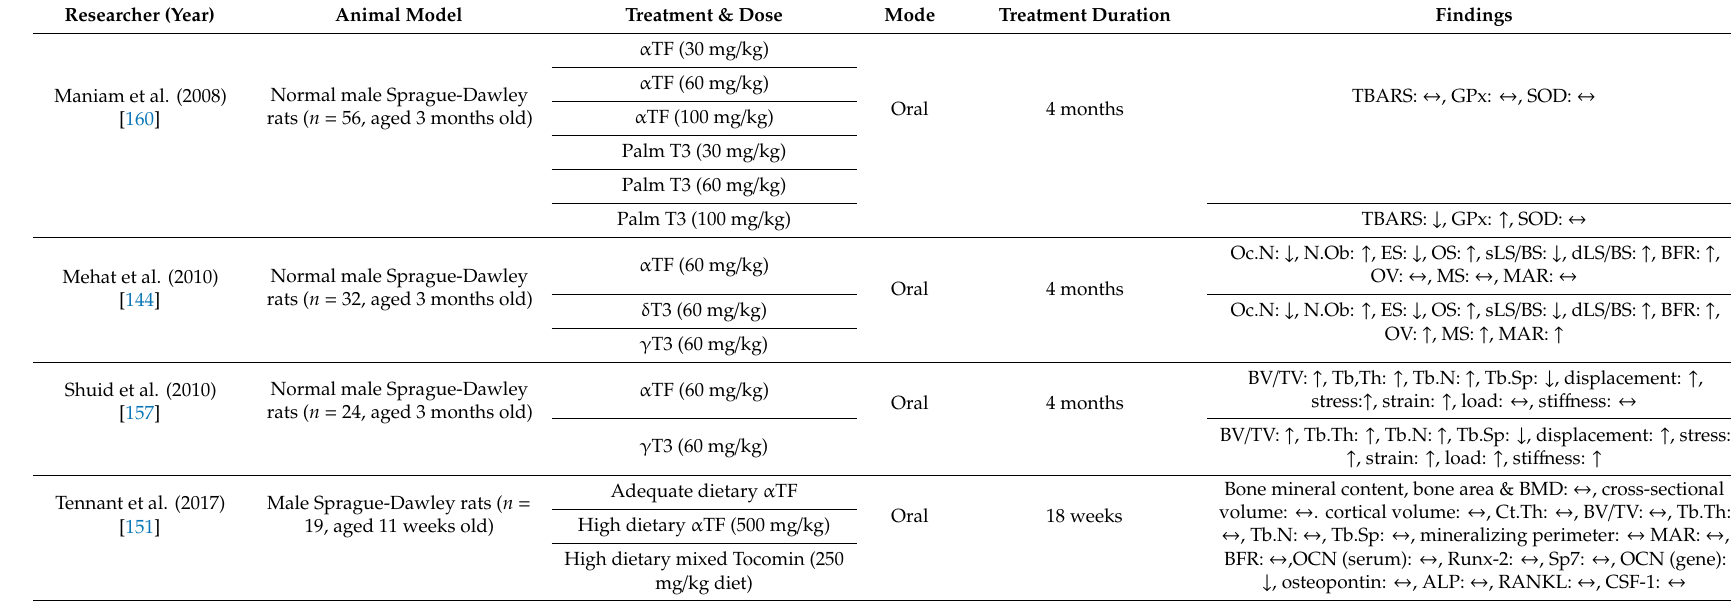
Table 8. E ff ects of T3 on osteoporosis in male rats.